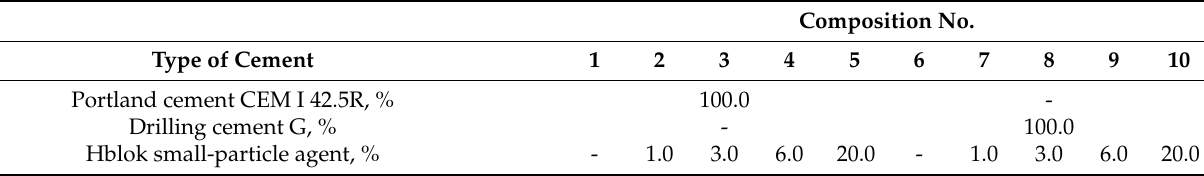
Table 1. Recipes of cement slurries with the addition of Hblock agent (water-cement coefficient 0.46). Composition